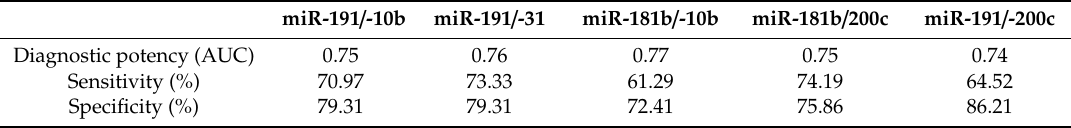
Table 4. The diagnostic potency of reciprocally dysregulated miRNA